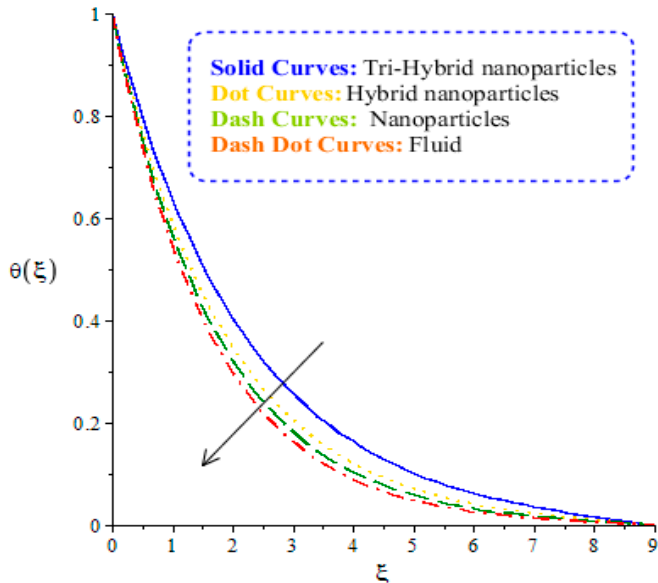
Figure 16. Comparative investigation among fluid, nanoparticles, hybrid nanoparticles and tri-hy-